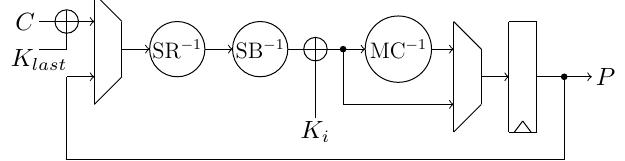
Figure 5: Guessed design architecture for the round-based AES decryption